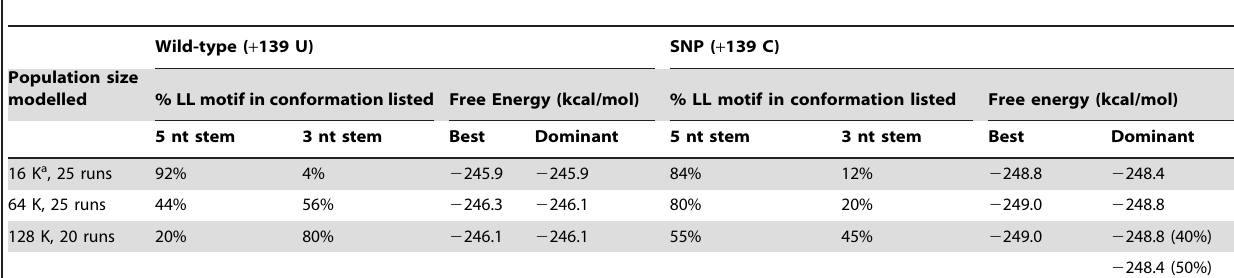
Table 3. Comparison of co-transcriptional models of the LL motif rRNA leader sequence ( + 1 to + 414) with C vs U at SNP site + 139.